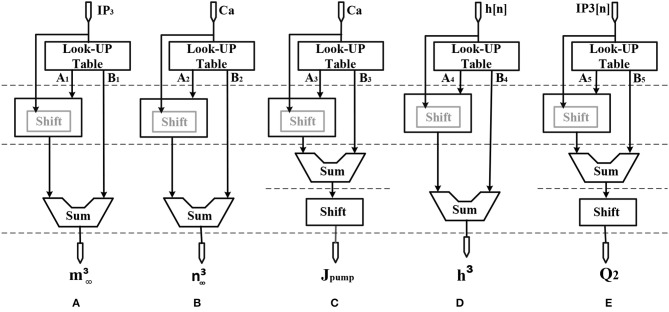
Scheduling diagram for (A)
m∞3[n], (B)
n∞3[n], (C)
Jpump[n], (D)
h3[n], and (E)
Q2[n].